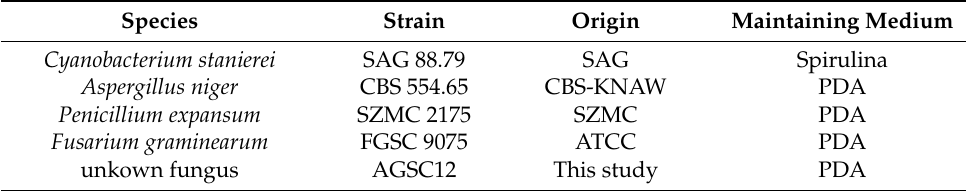
Table 1. List of strains used in this study. Species Strain Origin Maintaining Medium Cyanobacterium stanierei SAG 88.79 SAG Spirulina Aspergillus niger CBS 554.65 CBS-KNAW PDA Penicillium expansum SZMC